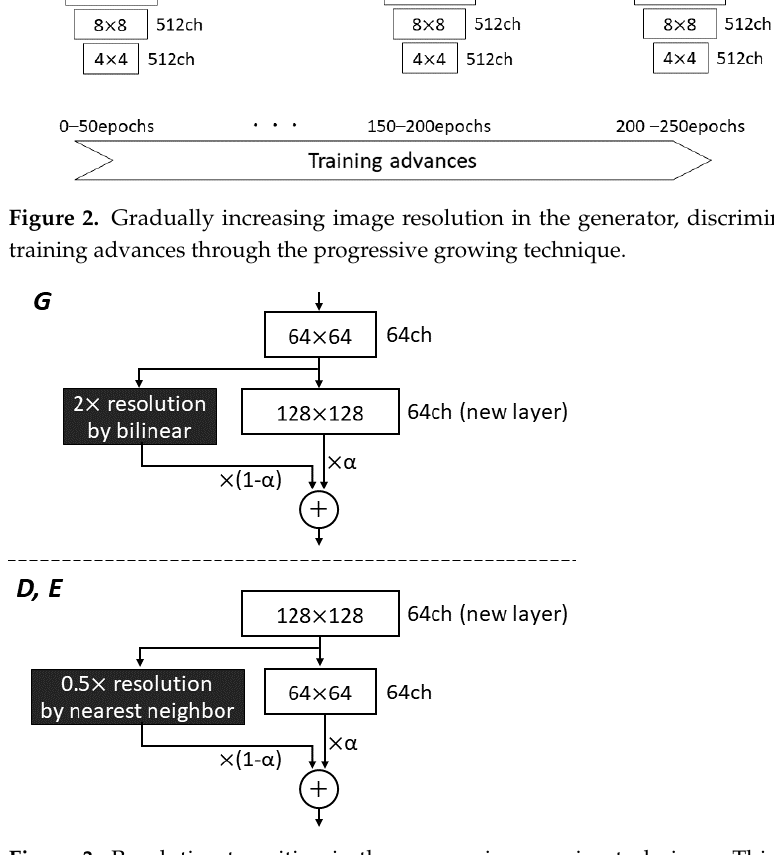
Figure 3. Resolution transition in the progressive growing technique. This is an example of the transition from 64 × 64 to 128 × 128 resolution. When a new layer generating a 128 × 128 feature vector is inserted into the generator, a 64 × 64 feature vector from the last layer is 2 × up-sampled using the bilinear method. The up-sampled vector weighted by (1- α ) and the newly inserted vector weighted by α are summed. In the discriminator and encoder, the newly inserted 128 × 128 image is translated to a feature vector with 64 channels and then down-scaled, using the nearest neighbor method, to 64 × 64 resolution. The weighted downscaled vector and vector from the next layer are also